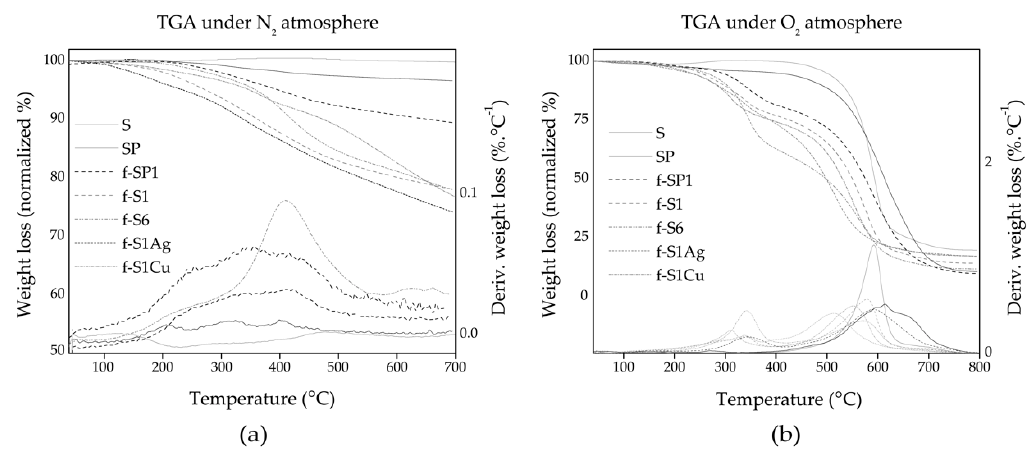
Figure 4. Normalized thermogravimetric analysis (TGA) curves and corresponding derivative: ( a ) under N 2 atmosphere for pristine, purified and functionalized SWCNT (f-SWCNT); ( b ) pristine, purified, f-SWCNT, and hybrid SWCNT (h-SWCNT), under O 2 atmosphere.